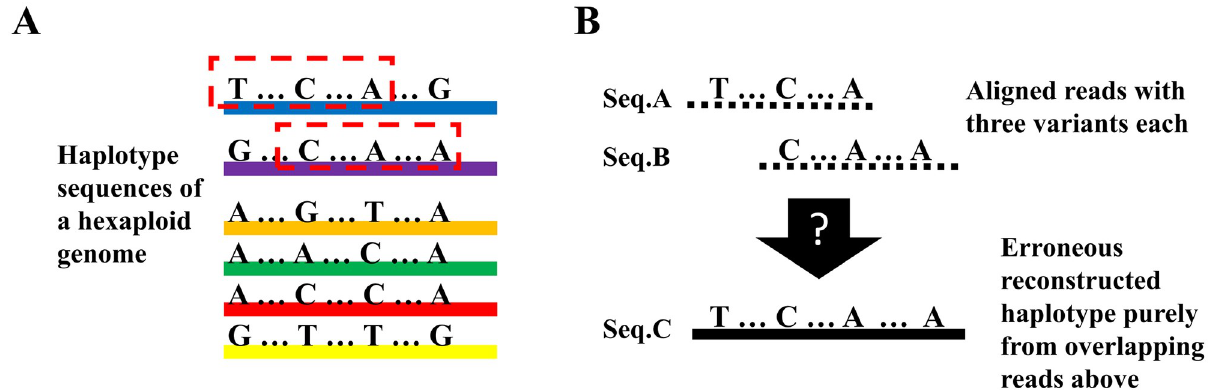
Fig 1. Ambiguity of merging fragments. In a polyploid genome, merging two fragments purely through sequence comparison may result in erroneously reconstructed haplotypes. (A) A region of a hexaploid genome with four variant sites. Each color indicates one true haplotype. (B) Seq.A and Seq.B are two reads sampled from the selected pieces of the blue and purple haplotypes, respectively. These sequences each carry three variants with an overlap of two variants ( C ... A ). Merging Seq.A and Seq.B would lead to Seq.C, which, however, is not one of the true haplotypes from (A) .